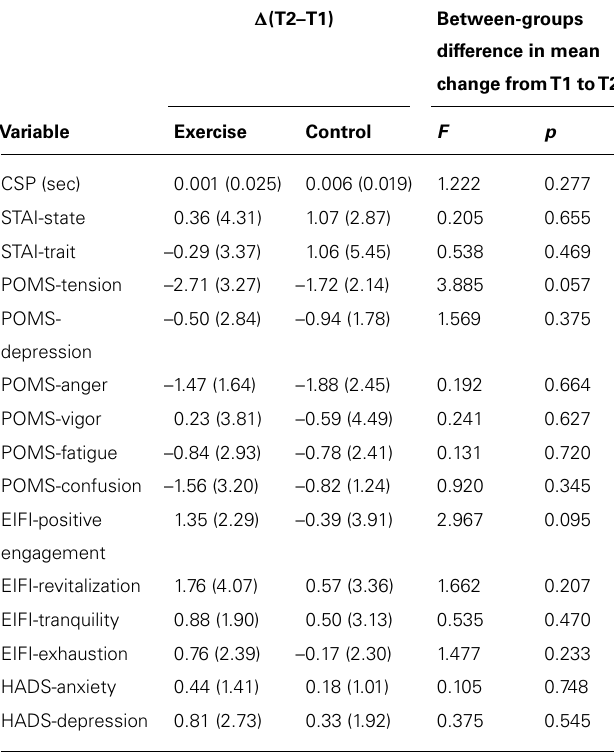
Table 2 |Acute effects of exercise on CSP and psychosocial outcomes. (cid:2)